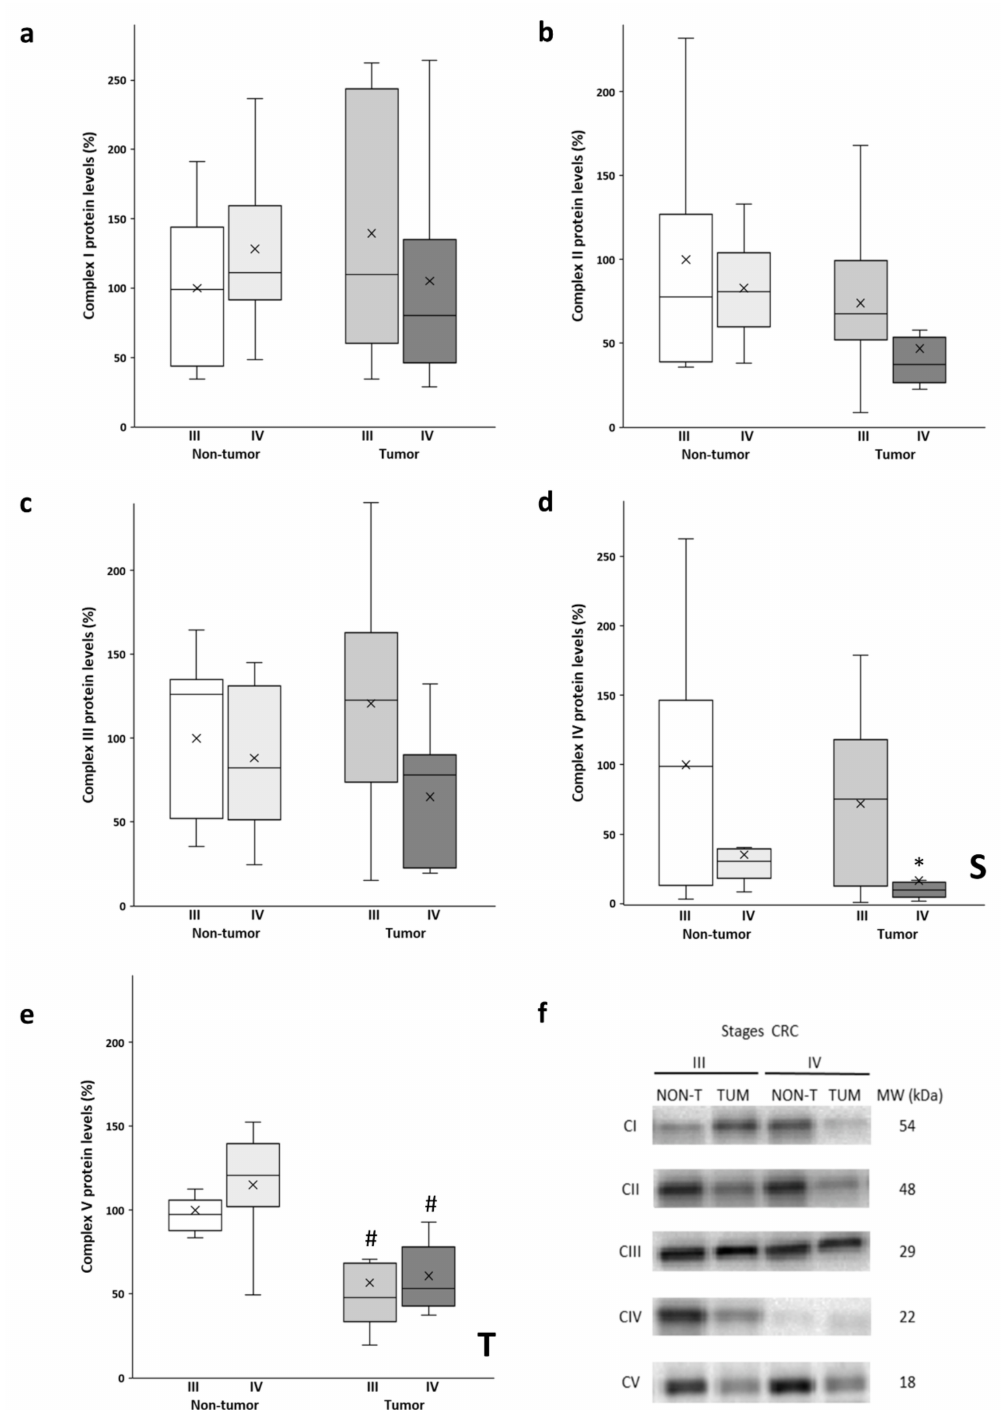
Figure 1. Boxplot of the protein levels of the OXPHOS complexes: Complex I ( a ); Complex II ( b ); Complex III ( c ); Complex IV ( d ) and Complex V ( e ). The X in each boxplot represents the mean. ANOVA analysis: two-way (n=11 per group): S, stage effect; T, tissue effect; one-way ( n = 11 per group): * difference between stage III and stage IV, # difference between non-tumor and tumor tissue; ( f ): Representative bands of the OXPHOS complexes; NON-T, non-tumor adjacent tissue; TUM, tumor